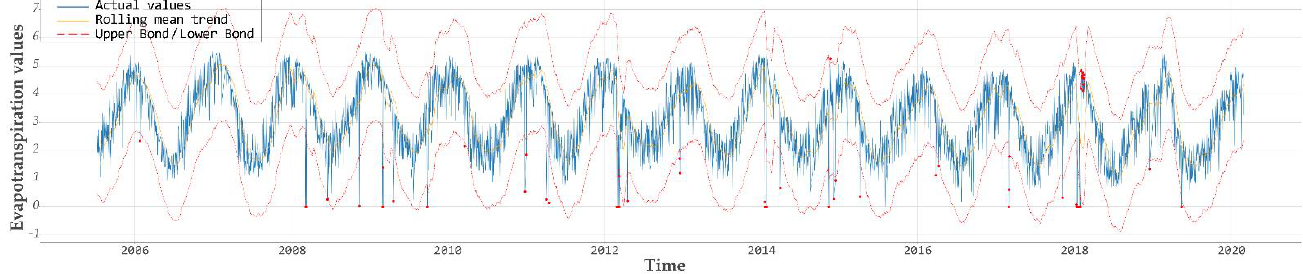
Figure 5. Visualization of out-of-range evapotranspiration values using moving averages.